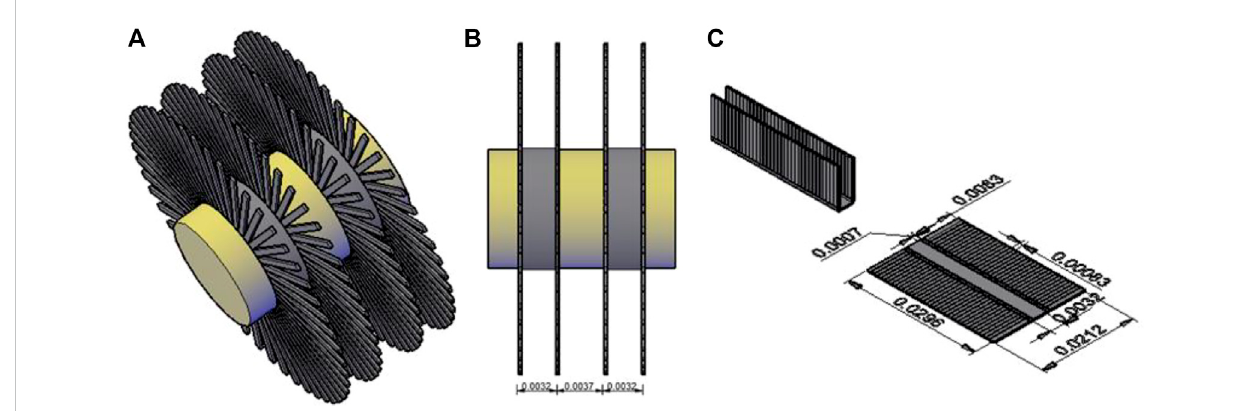
TABLE 1 Primary dimensions of the